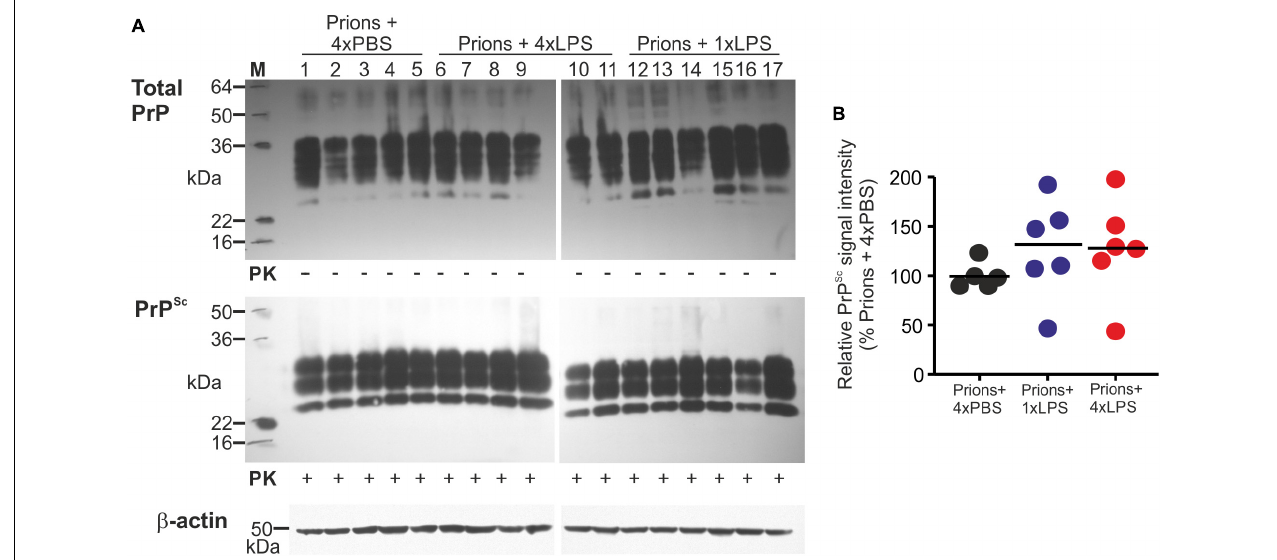
FIGURE 8 | Effect of systemic LPS treatment on prion disease-specific PrP Sc accumulation in the brain. Mice were first injected with ME7 scrapie prions directly into the brain by IC injection. Thirty five days later the mice were given a either single IP LPS injection (prions + 1xLPS) or four consecutive daily IP LPS injections (prions + 4xLPS) to induce innate immune training or tolerance, respectively. A parallel group of mice were given four consecutive daily IP PBS injections (prions + 4xLPS) as a control. Brains were collected at the terminal stage. (A) Western blot analysis of prion disease specific PrP Sc accumulation in half brains from each group. PK, proteinase-K. Upper panel, total PrP; middle panel, relatively PK-resistant prion disease-specific PrP Sc ; lower panel β -actin. (B) Quantitation of the relative abundance of PrP Sc in half brains from each group. The abundance of PrP Sc in each sample was expressed as the% relative to the mean value in the 1xPBS-treated controls. N = 5–6 mice/group; horizontal bar in histograms,